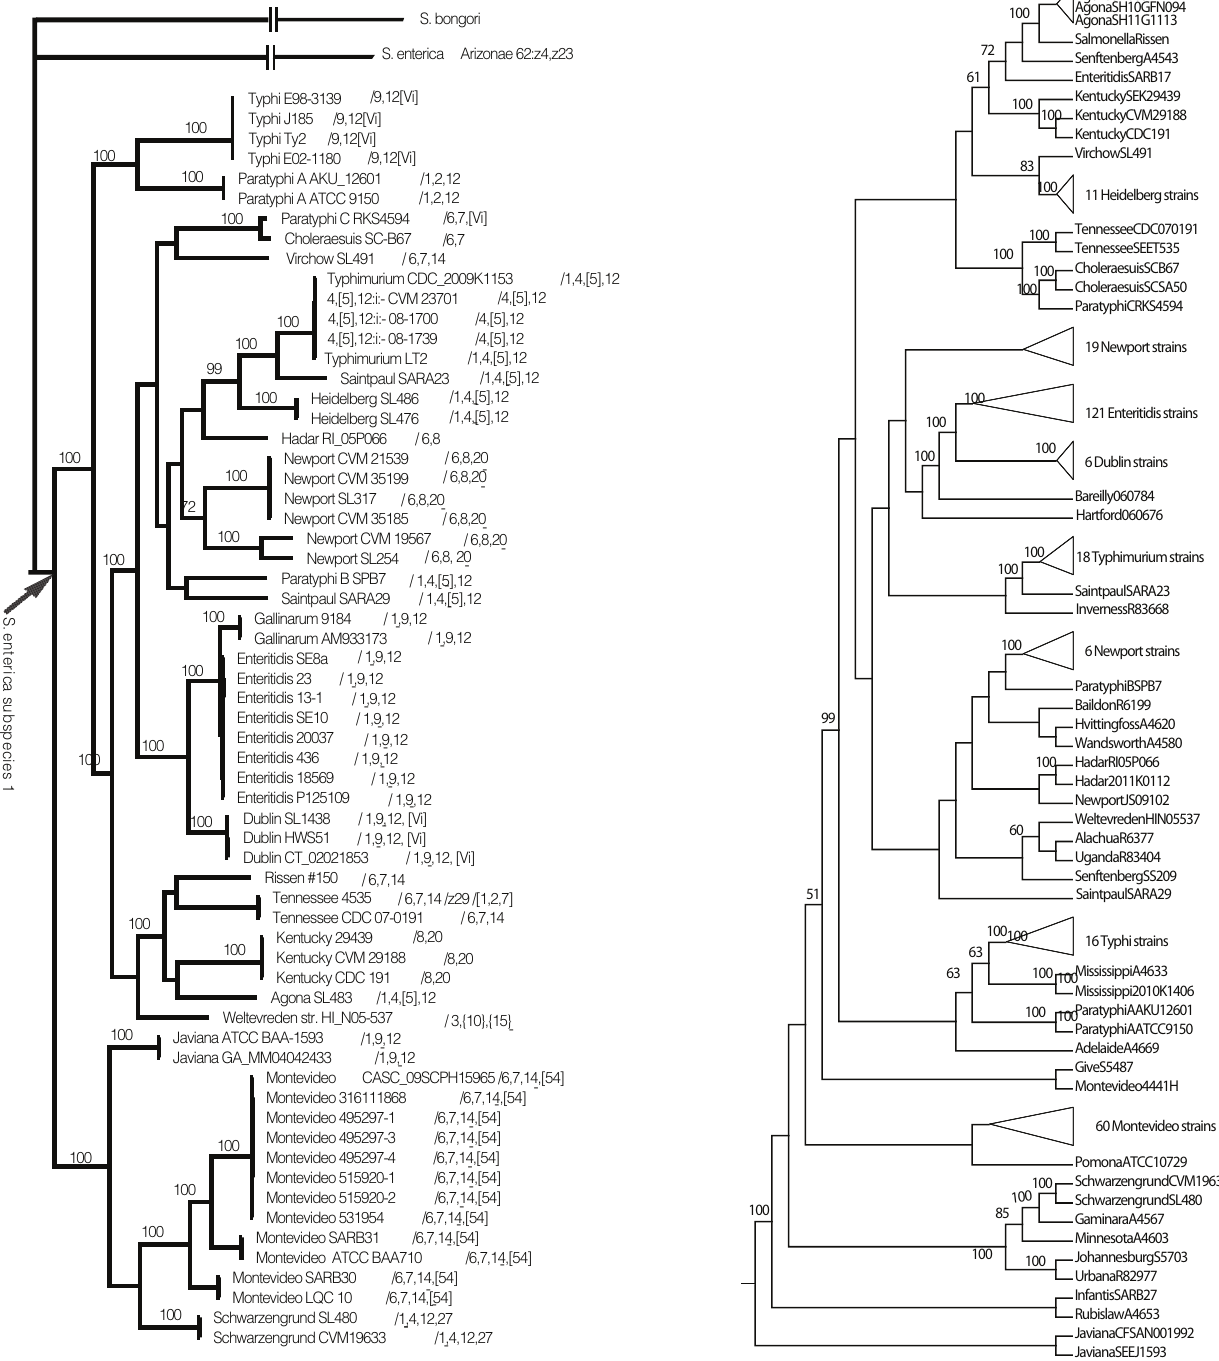
Figure 1. The strict consensus tree of the 321 most-parsimonious trees based on the nucleotide substitutions for 937 genes (A). This tree postulates an evolutionary hypothesis that classifies most operational taxonomic units as monophyletic within the same O-antigen serovar but shows that the 1,4,5,12:i:- O-antigen complex is polyphyletic. Bootstrap percentages of 50% and over are listed above nodes, except those leading to taxa that are grouped together by branch lengths too short to be visible on the figure. The Salmonella enterica subspecies I clade is indicated with an arrow. The branch lengths leading to the out-groups S. bongori and S. enterica subspecies arizonae are not drawn to scale as denoted by the broken branches leading to these taxa. The rest of the branch lengths are drawn to scale. Panel (B) shows the majority rule bootstrap consensus tree using only the information contained in the 27 predicted PCR amplicon sequences of 317 strains of S. enterica subspecies I. It is rooted with the Salmonella enterica subspecies I serotype Javiana clade. Clades containing only members of the same serovars are collapsed into a single schematic. Many of the schematic-depicted clades often had internal resolution (See Figure S1).